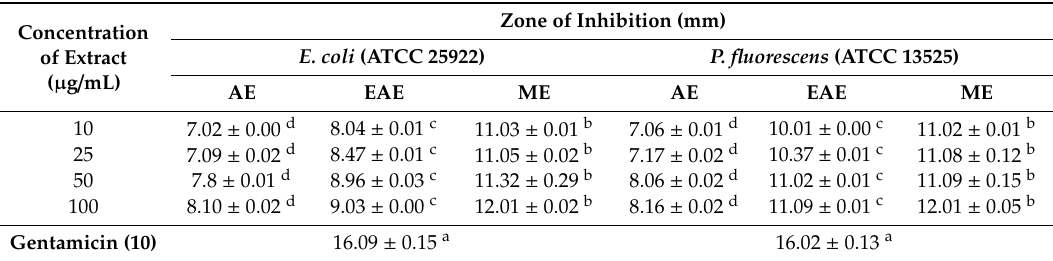
Table 8. Activity of di ff erent M. esculenta leaves extracts against Gram-negative bacteria.